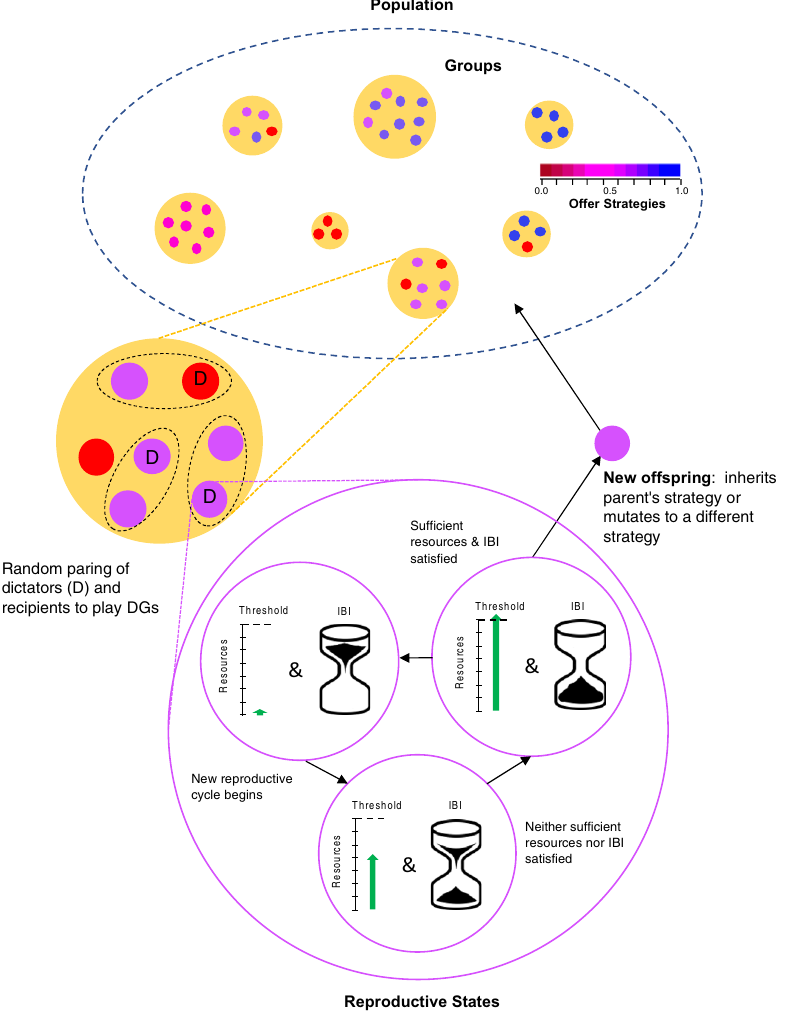
Figure 1. An illustration of the IBI model of the evolution of equitable offers strategies in n -person DGs. At the top is a population consisting of groups with individual agents color coded by strategy. Some agents in each group are randomly assigned a resource endowment and then agents are randomly assigned to play DGs within a group (dashed ovals in the magnified group indicate DGs). Agents accumulate reproductive resources (green) from playing DGs and when an agent has accumulated sufficient resources (reaches or passes the resource threshold) and the IBI is complete (“hourglass” is finished), an offspring agent is born, which either inherits the parent’s offer strategy or mutates to a different offer strategy. Resources required to reproduce are subtracted and the IBI is reset to its initial state (“hourglass” is flipped